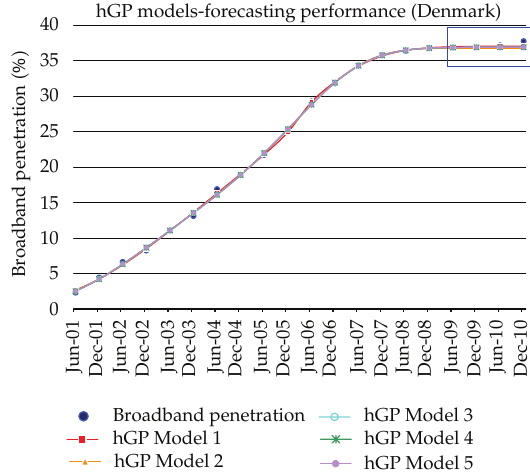
Figure 26: The forecasting performance of the first five hGP models for Denmark (cid:2) forecast period—2 years ahead (cid:3)